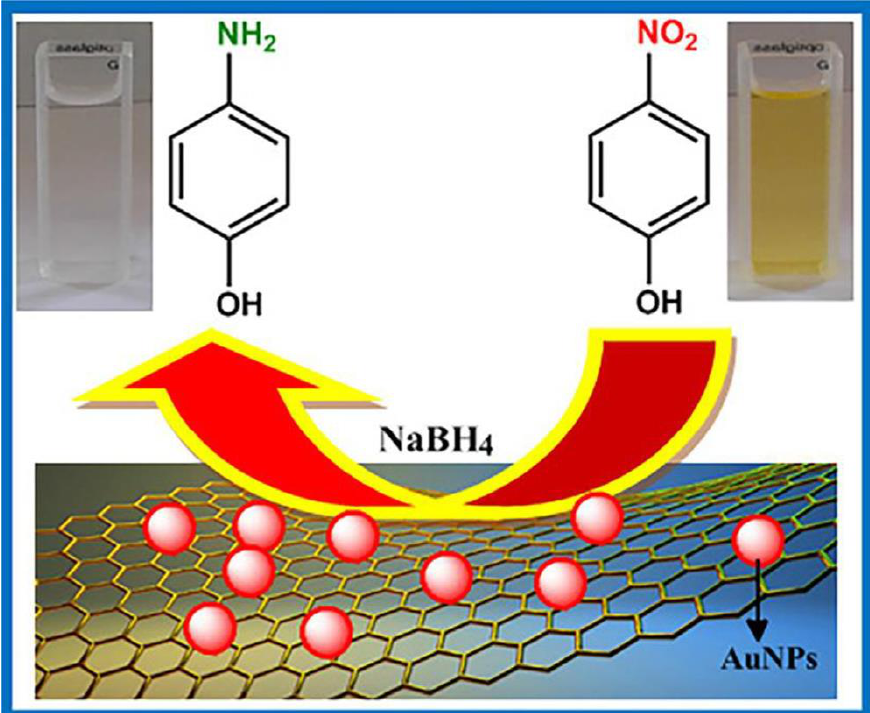
Figure 15. The reduction mechanism of p-Nitrophenol using a reducing agent and catalyst. Reprinted from ref. [212] with permission.